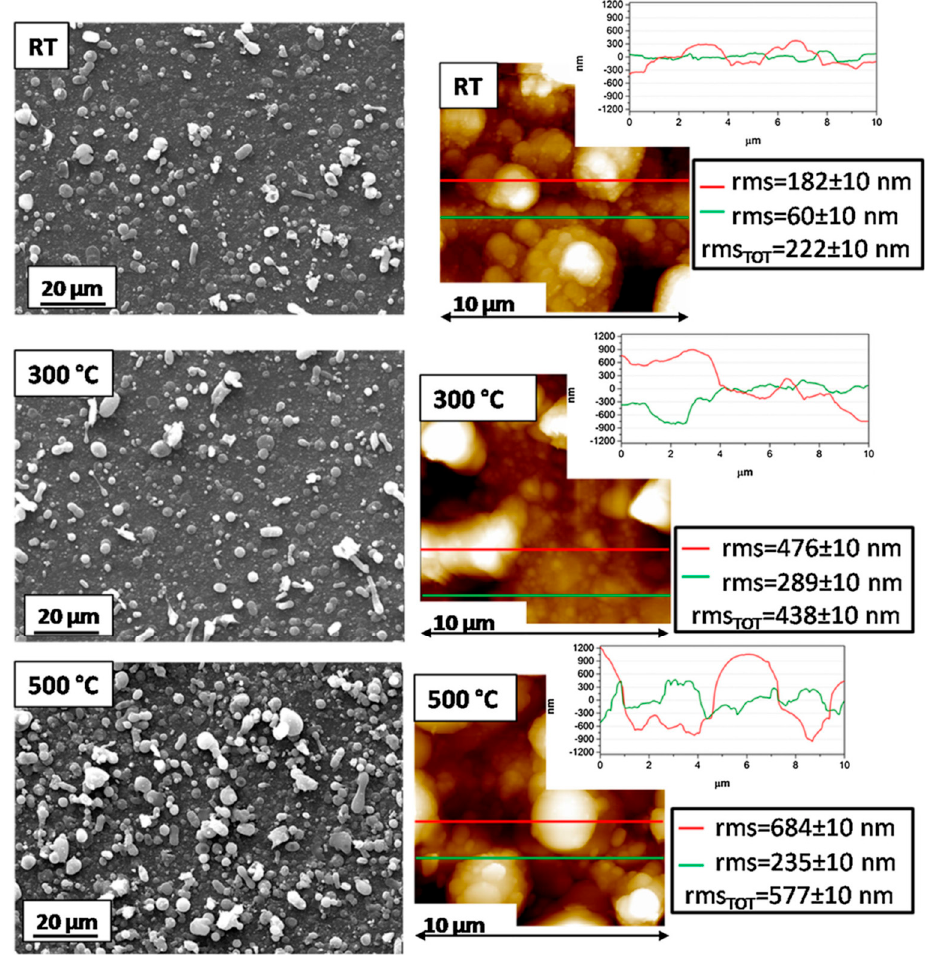
Figure 6. Effect of deposition temperature on BGC film growth. Reproduced with permission from [148], copyright from 2017 Springer.